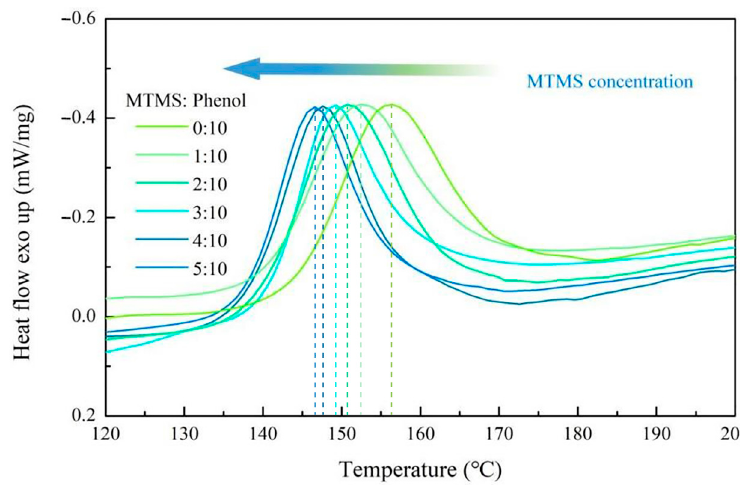
Figure 7. DSC of SMPR with different MTMS content of phenol.